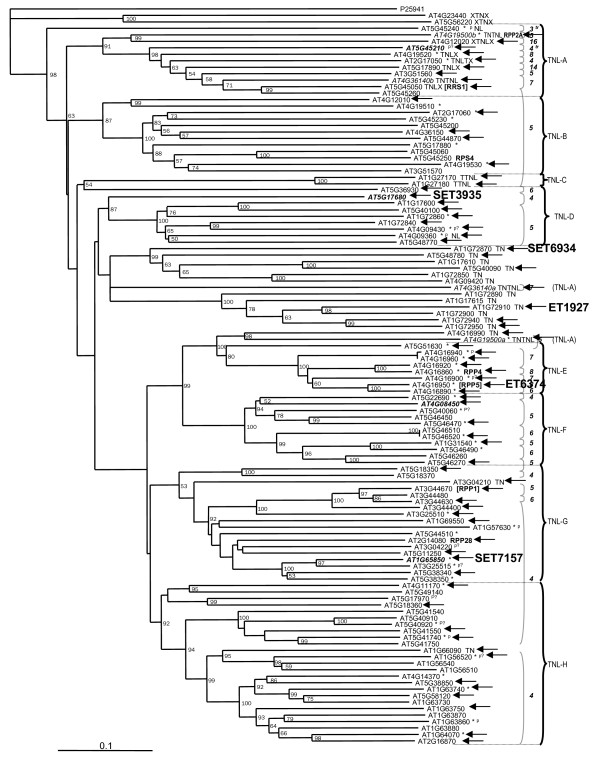
The distribution of TIR-NBS-LRR-encoding and related genes analyzed on neighbor-joining tree generated by Meyers et al. [7]. The genes studied by RACE are indicated by black arrows, the genes analyzed using RT-PCR are displayed in bold italic, and NBS-LRR-encoding and related genes with enhancer trap insertions are marked in bold. Other figure denotations are as described in Meyers et al. [7].